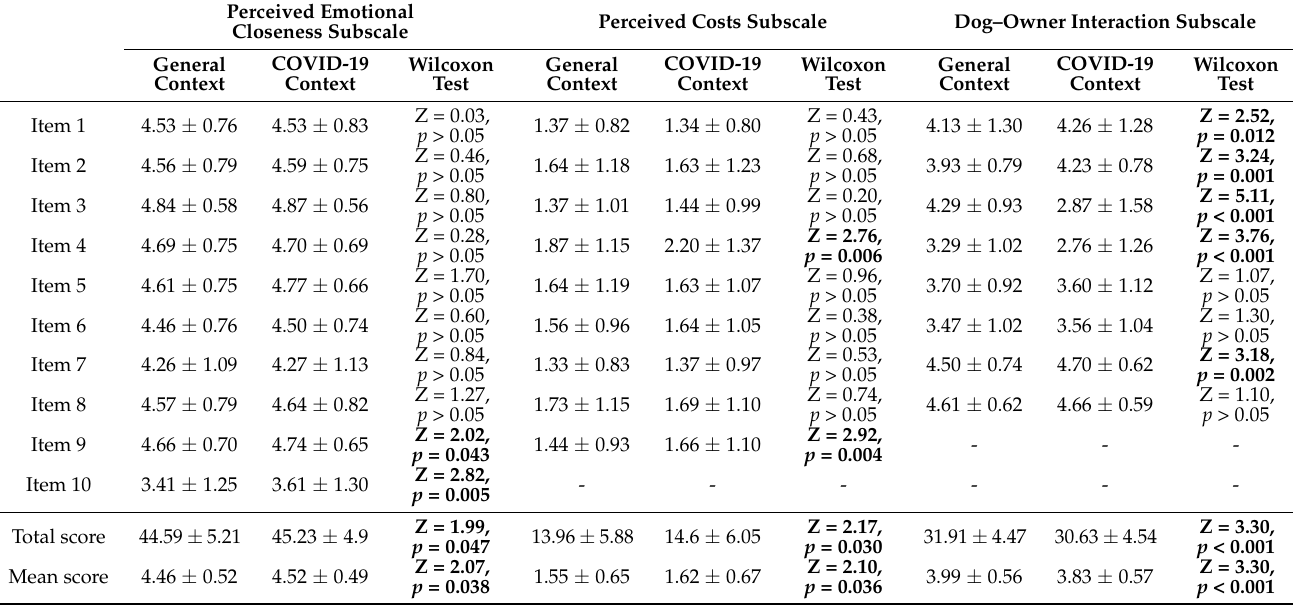
Table 2. Scores for items on each subscale of the MDORS during the COVID-19 lockdown and in a general context (mean ± SD). Significant differences between contexts (i.e., the COVID-19 lockdown vs. General context prior to COVID-19 lockdown) are in bold—level of significance: p < 0.05 (Friedman tests). Number of item corresponds to the order of items in the MDORS questionnaire developed by Dwyer et al.